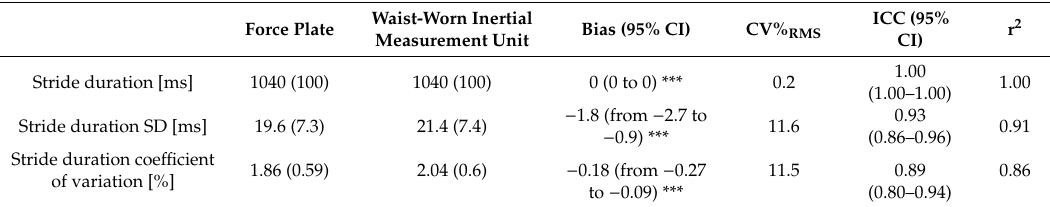
Table 3. Concurrent validity of stride characteristics measured with a force plate and a waist-worn inertial measurement unit (session 1).